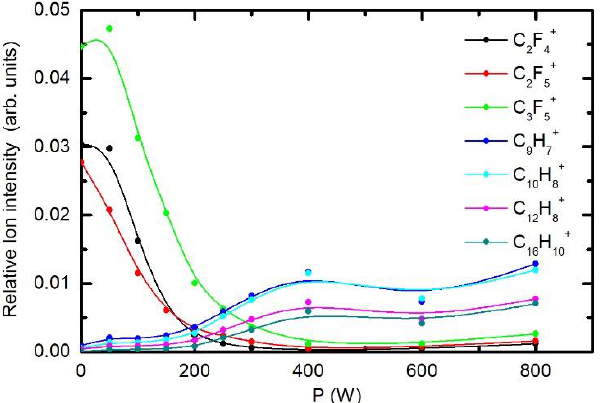
Figure 12. Variation of ToF-SIMS intensities of selected positive ions. The pressure was 25 Pa and treatment time 1 s.